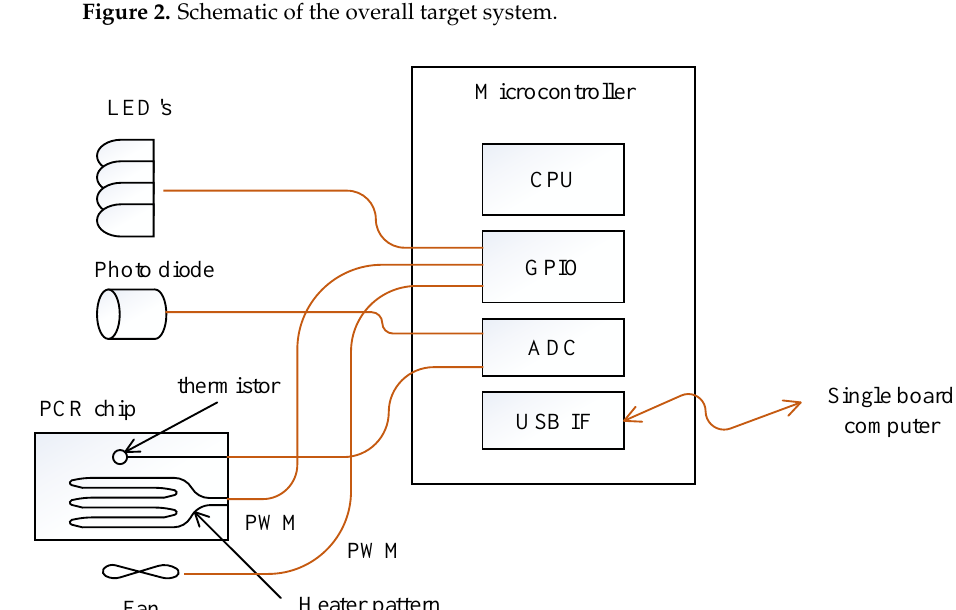
Figure 3. Schematic of the microcontroller and its peripheral. The connection between the microcon- troller and excitation LEDs and PCR chip is also illustrated.